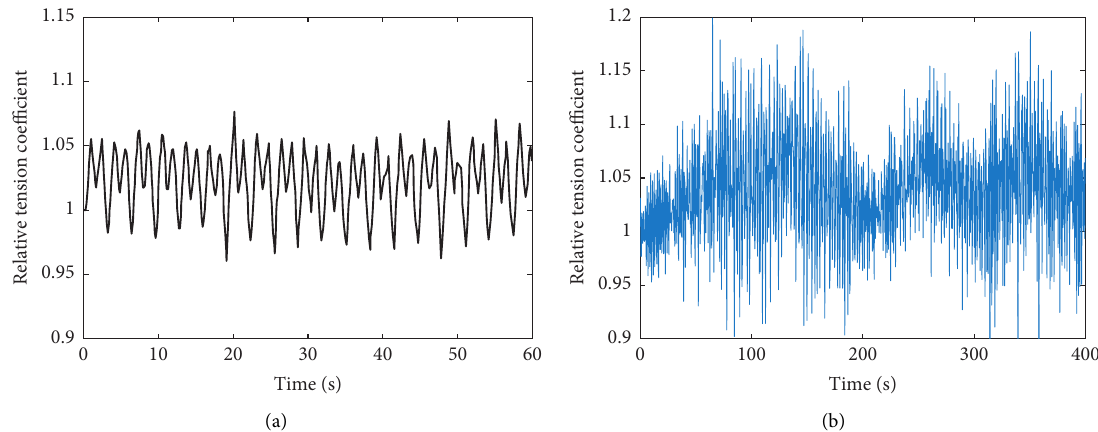
Figure 9: Dynamic relative tension coefficient variation curve with time: (a) field test record. (b) Simulation results under the adaptive excitation proposed in this article.